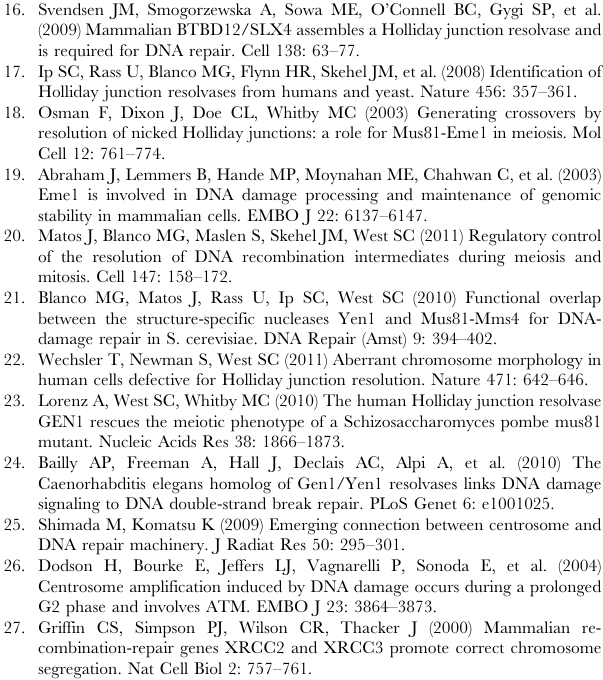
fixed and immunostained with the indicated antibodies. Graph represents the mean of three independent experiments. (n =300 cells/condition/experiment). Scale bar, 10 m m. Figure S4 GEN1 depletion reduces HDR. A. MCF7 cells were treated with the indicated siRNAs for 48h, then CPT (5 m M) was added and cells were harvested 1 h later. For ATM inhibition (ATMi), cells were pretreated 1 h with 10 m M ATM inhibitor before CPT incubation. Cells were process for analysis by immunoblotting with the indicated antibodies. B. HeLa cells were treated with CTRL or GEN1 siRNA for 48 h and then treated with the indicated doses of hydroxyurea (HU) for another 48 h. After methanol fixation cells were co-immunostained with GEN1 and c -tubulin antibodies. Histogram represents the mean of three independent experiments. (n= 300 cells/condition/ experiment. C. 48 h following siRNA treatment with the indicated siRNAs U20S/DR-GFP cells were transfected with I-SceI plasmid for 48 h. Cells were process for analysis by immunoblotting with the indicated antibodies or total RNA was purified and the mRNA levels of SLX4, GEN1, Rad51C were examined by